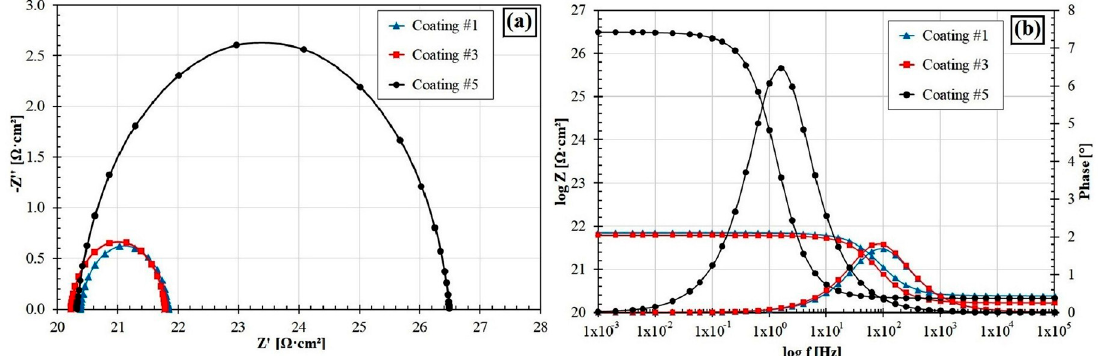
Figure 9. Electrochemical Impedance Spectroscopy diagrams of produced coatings: ( a ) Nyquist plots, ( b ) Bode plots (specimen numbers in accordance with Table 2).